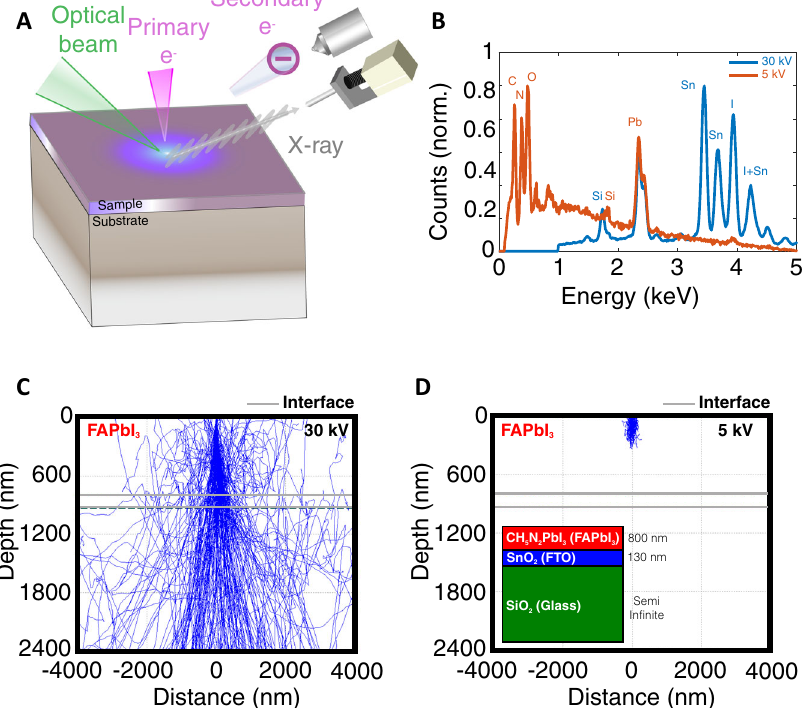
30keV, and ( D ) 5keV.While the primary electronscan penetrate the entire sample stack at 30keV, those at 5keV are mostly con fi ned within 200nm near the FAPbI 3 surface. The interfaces between FAPbI 3 and fl uorine doped tin oxide (FTO), and between FTO and the glass substrate are labeled with gray lines. The inset in D shows the structure of the FAPbI 3 sample